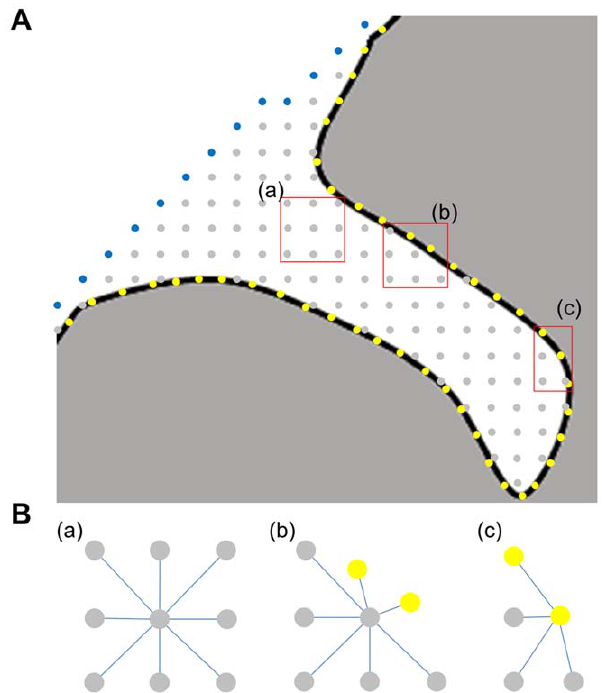
Figure 3. An illustrative figure to show the local coordinates. (A) Local coordinates, (B) ‘‘Accepted’’ nodes and their ‘‘Considered’’ nodes with temporary edges. Gray nodes are in the voxel space between the convex hull (blue nodes) and the cortical surface (yellow is indicated by the length of the blue line. nodes). The edge cost C ijk n